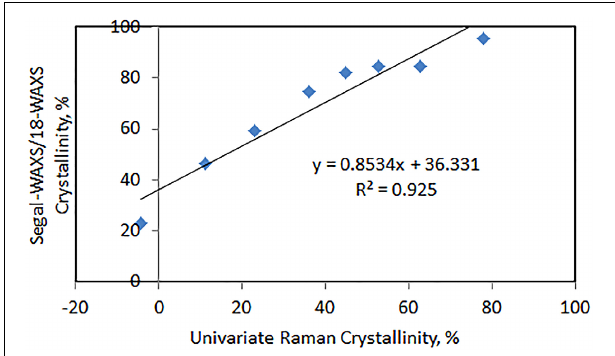
FIGURE 3 | Correlation between 18-Segal-WAXS and univariate Raman crystallinities.